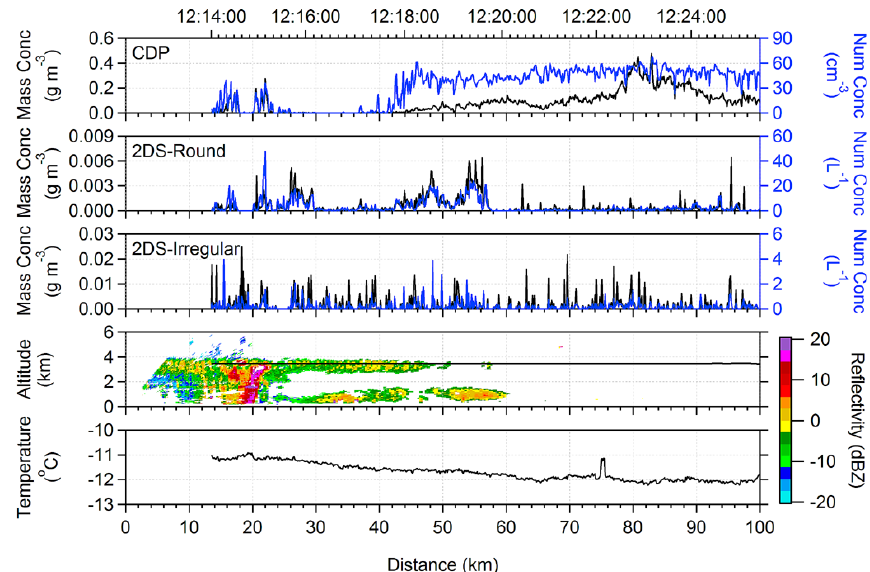
Fig. 5. Total particle mass (left axes, black lines) and number (right axes, blue lines) from the CDP and 2DS as a function of distance/time from CFARR. Data from the 2DS are separated into round and irregular categories. In-situ temperature from the de-iced Rosemount sensor is also shown. Data are from the BAe146 aircraft along the 253 ◦ radial during constant altitude run R2. Also shown is the reflectivity from